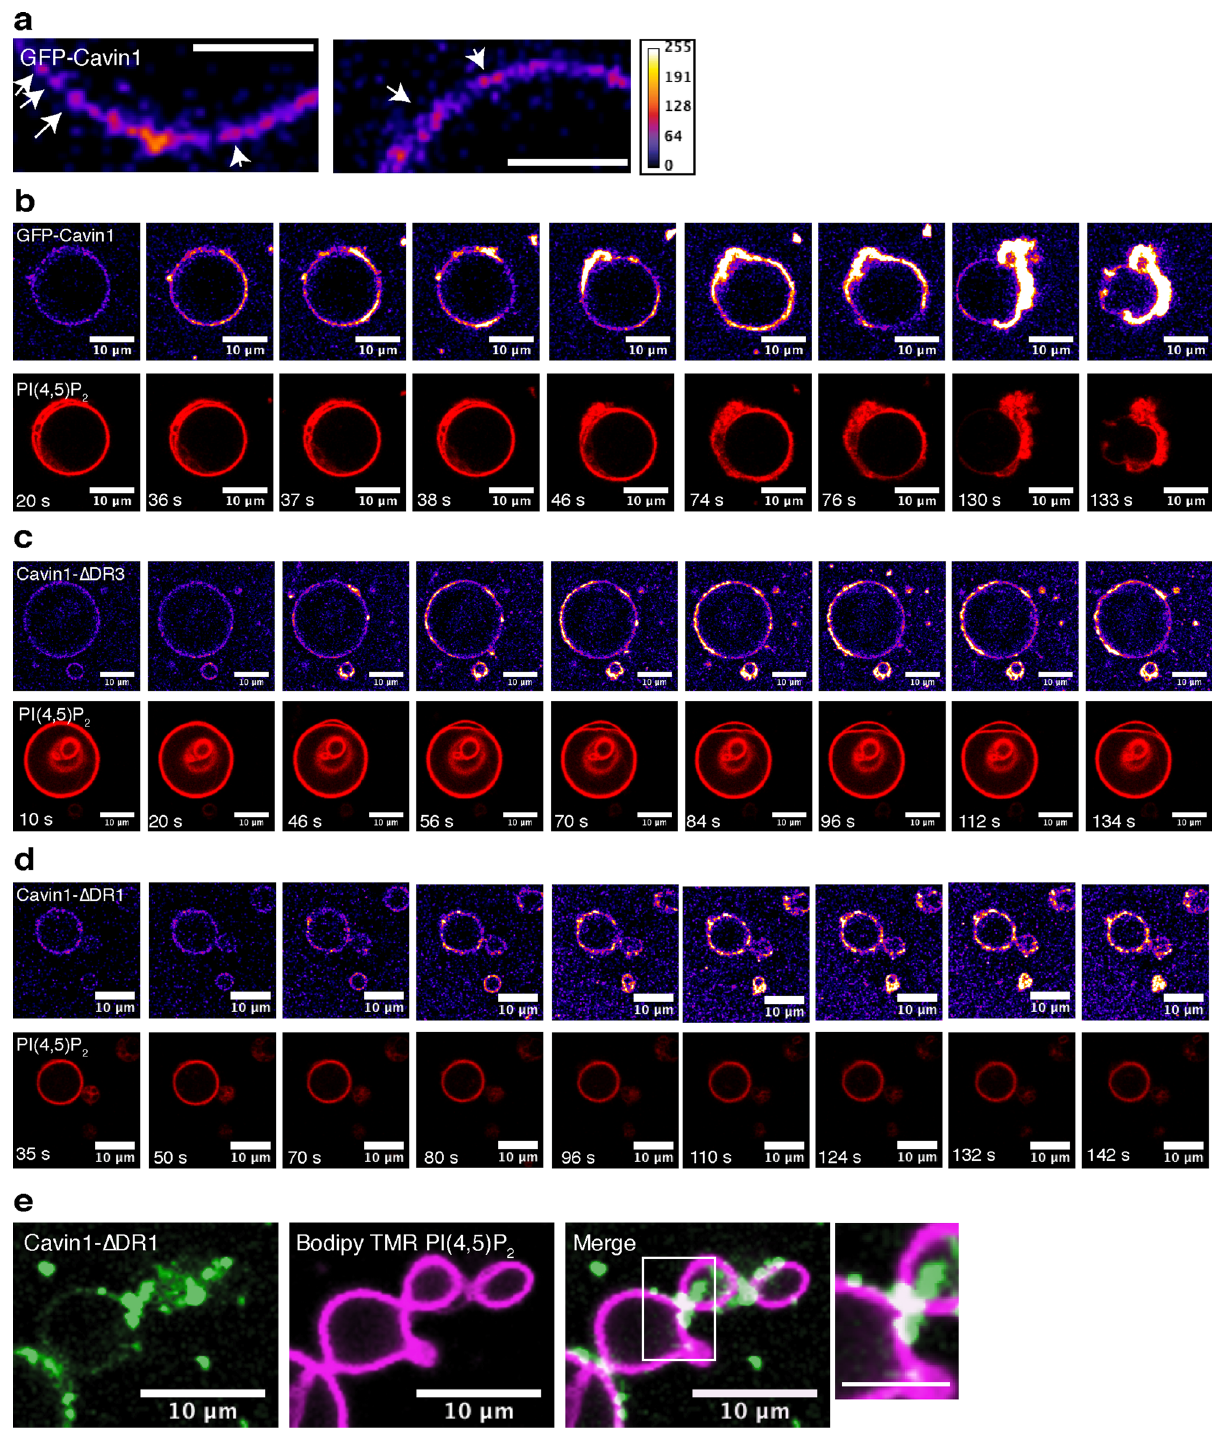
Fig. 5 Removing the Cavin1 DR domains prevents deformation of GMV membranes. a Puri fi ed Ub-tagged and GFP-tagged Cavin1 shows strong localised clustering on the surface of Folch giant multilamellar vesicles (GMV) containing Bodipy-TMR-labelled PI(4,5) P 2 (0.1 mol%). Scale bar = 5 μ m Cavin1 ( b ), Cavin1- Δ DR3 ( c ) or Cavin1- Δ DR1 ( d ) were incubated with Folch GMVs containing Bodipy-TMR-labelled PI(4,5) P 2 (0.1 mol%), allowed to settle on glass coverslips and images were acquired one frame per second. Frame numbers are indicated in PI(4,5) P 2 channel (red). e GMVs incubated with Cavin1- Δ DR1 were often observed to be tethered to each other with Cavin1- Δ DR1 concentrated at the contact sites. Scale bar = 10 μ